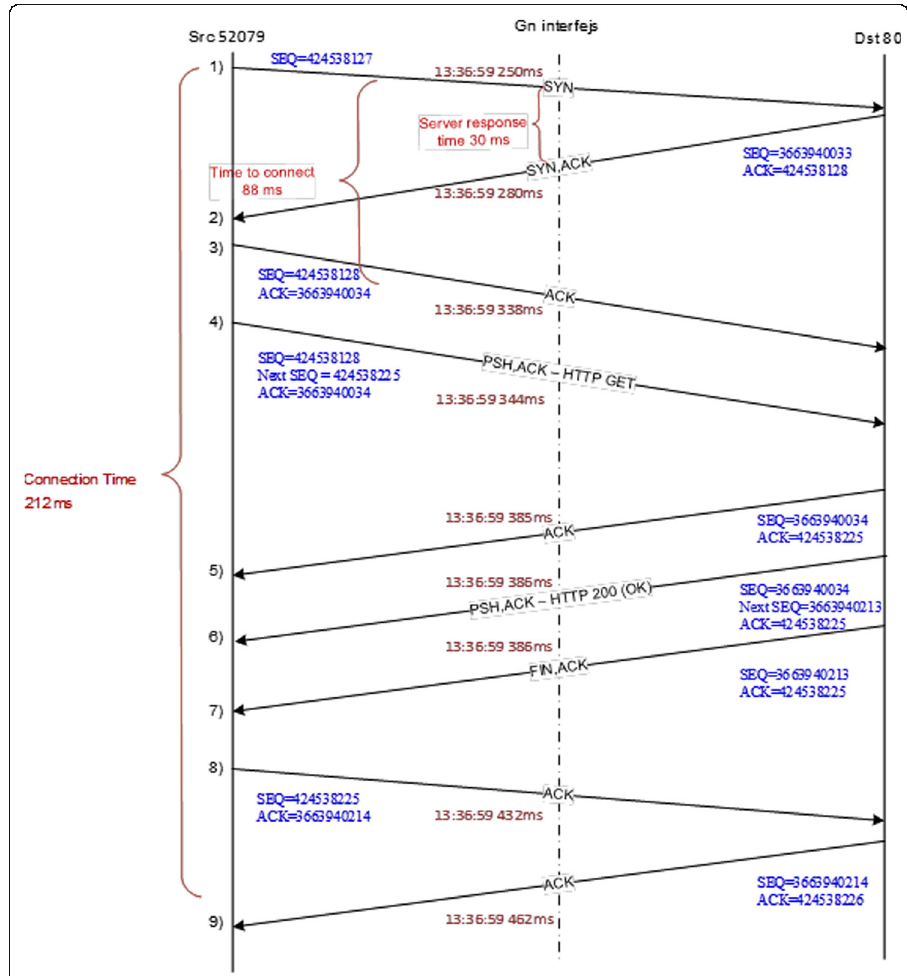
Fig. 2 Characteristic times for TCP session record on Gn